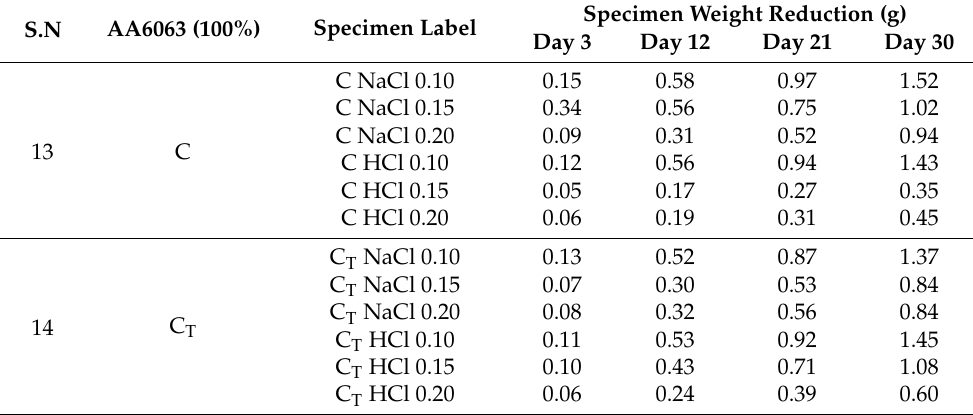
Table 11. Control specimens C and C T weight reduction in HCl and NaCl.